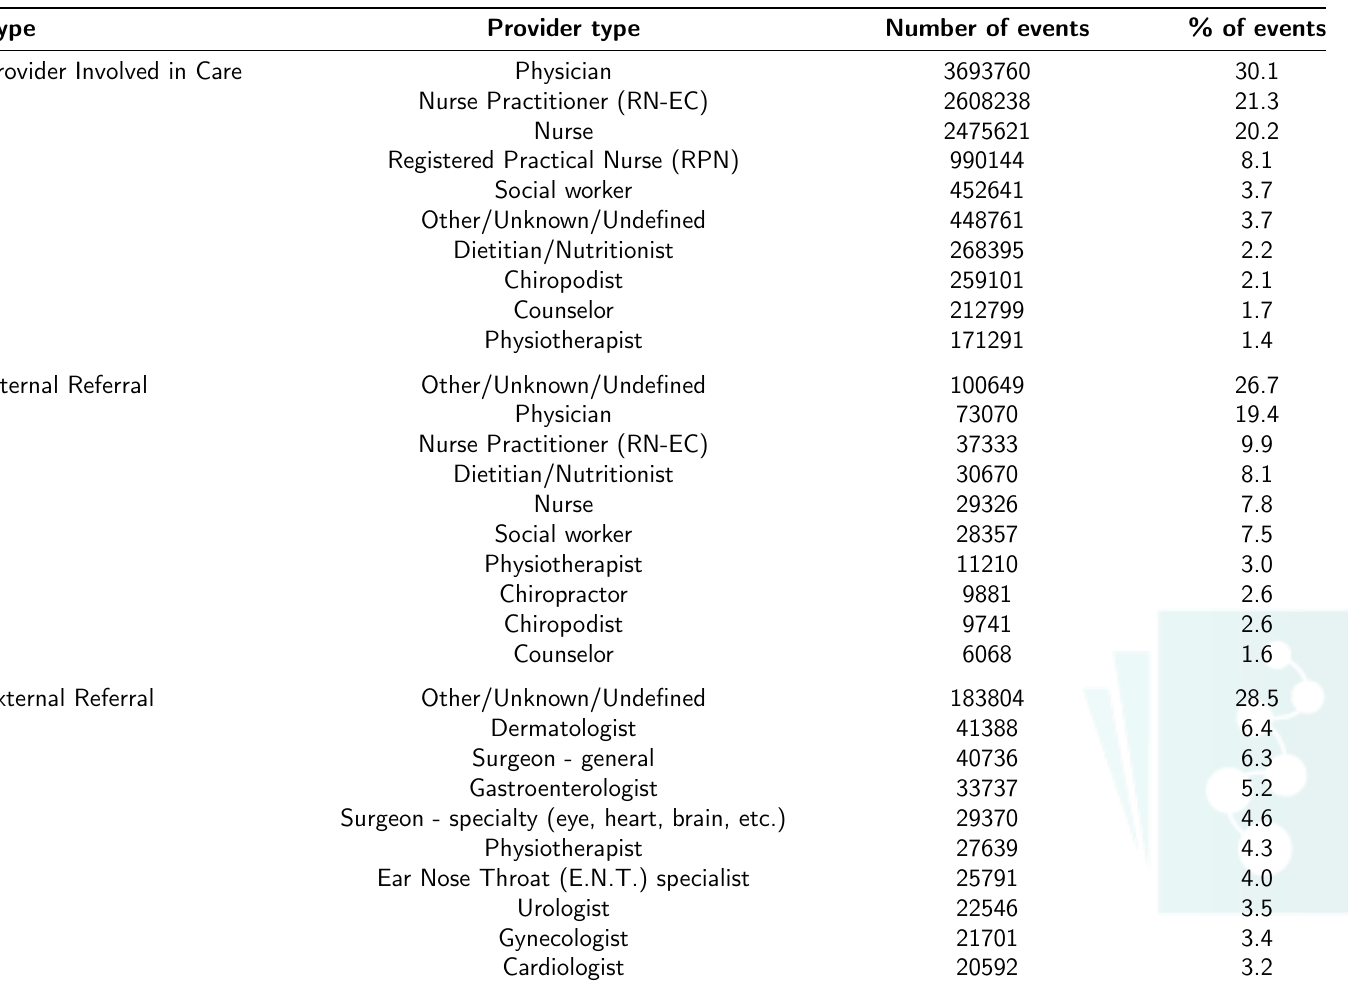
Supplementary Table 4: Provider type